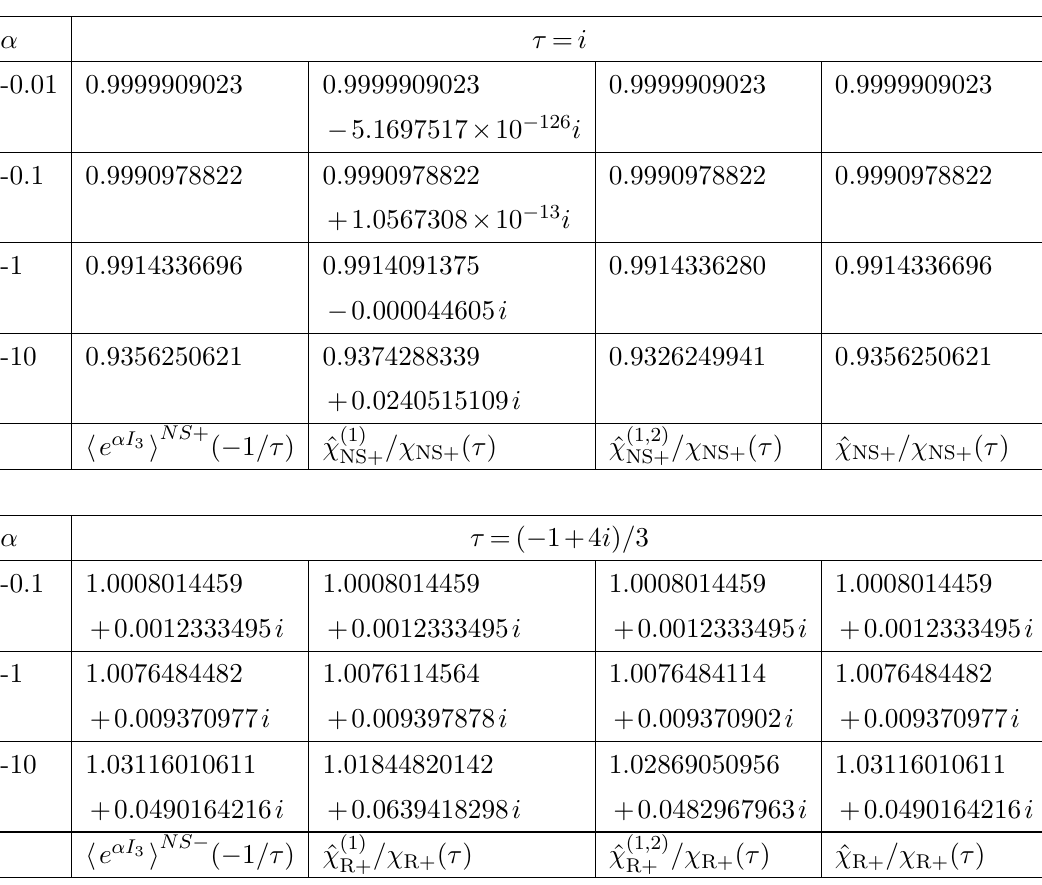
3 in two different